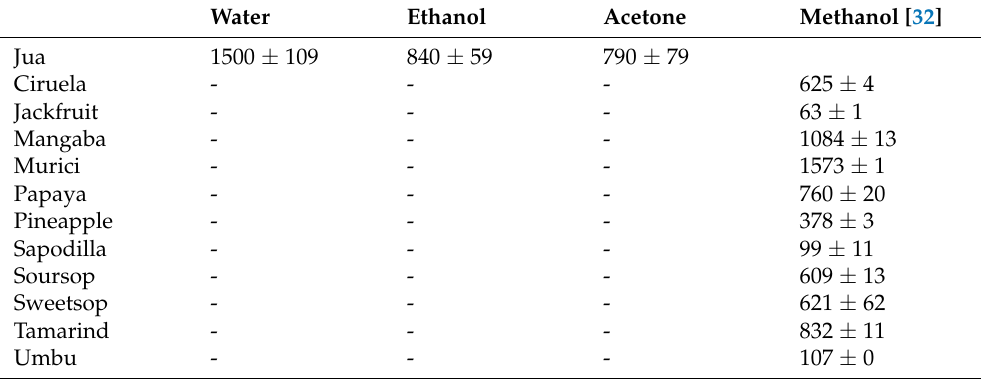
Table 4. Trolox equivalent antioxidant capacity (TEAC, µ mol TE/100 g fw) of jua pulp extracts obtained by ultrasound-assisted extraction with water, ethanol, and acetone compared with results for methanol extracts from exotic fruits obtained from the